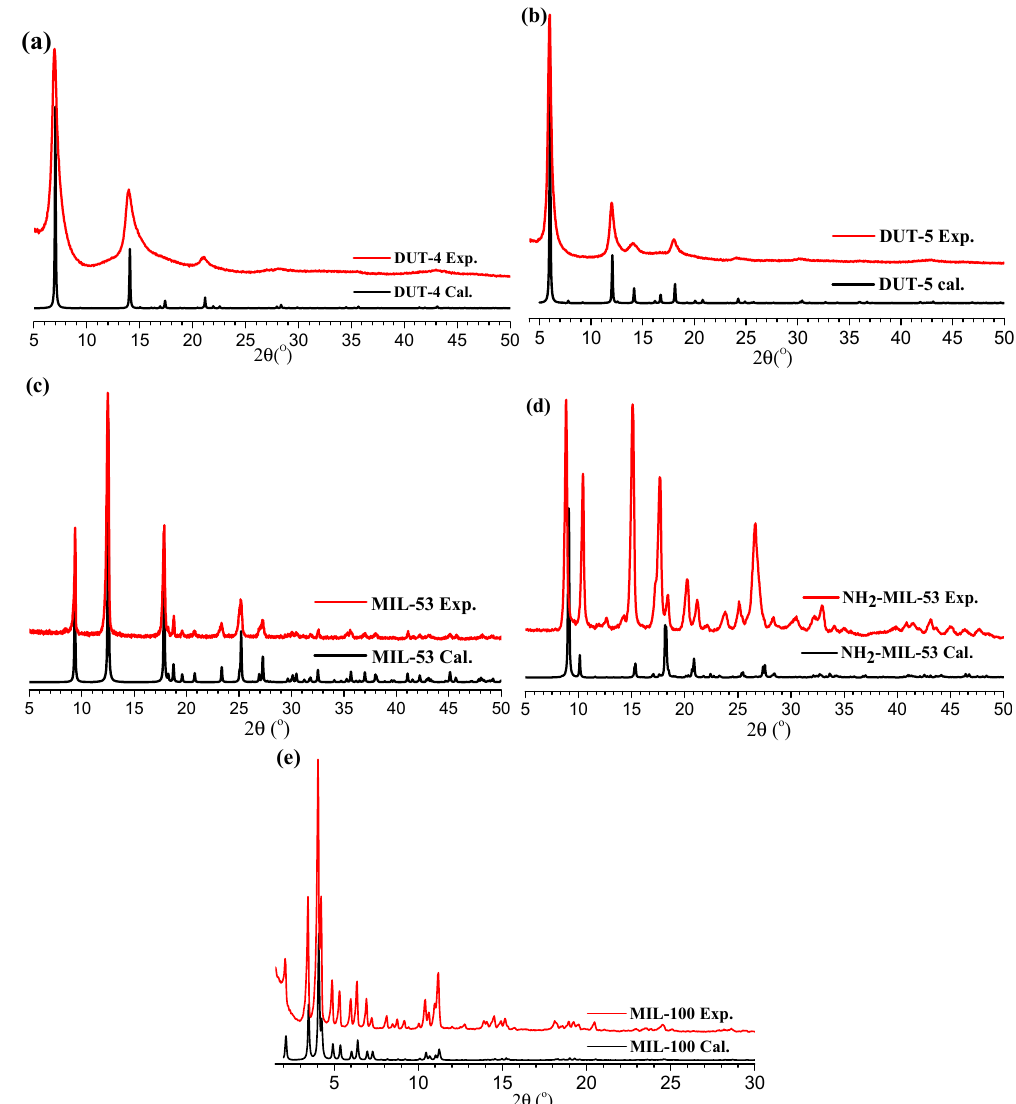
Figure 1. The comparison of PXRD patterns of activated MOFs: ( a ) DUT-4; ( b ) DUT-5; ( c ) MIL-53; ( d ) NH 2 -MIL-53; and ( e ) MIL-100 with their calculated PXRD patterns.